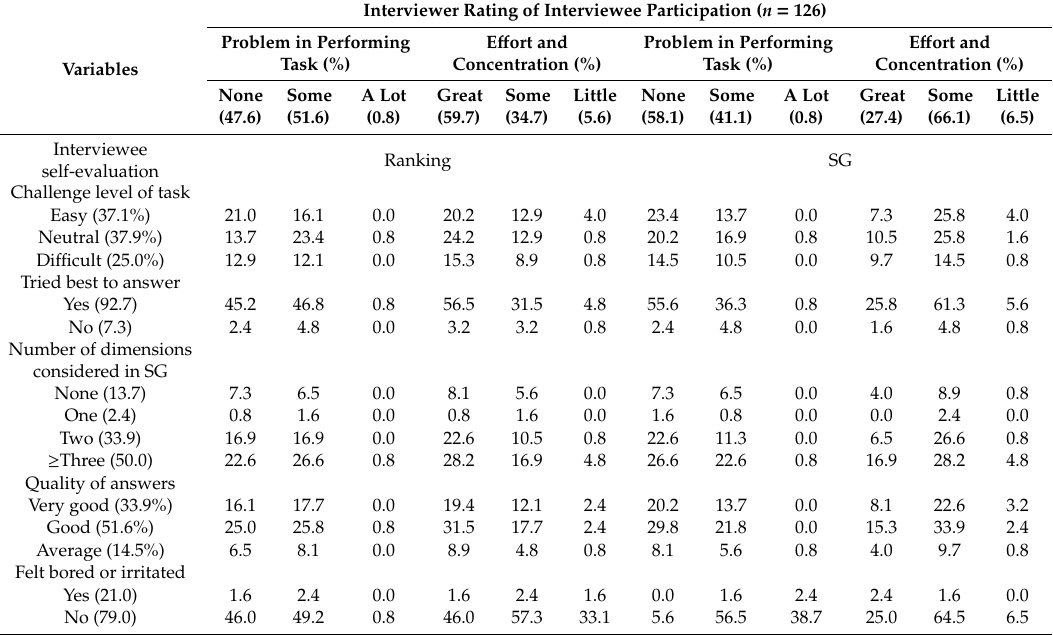
Table 2. Feasibility and acceptability of the SG and ranking for the SF-6D descriptive